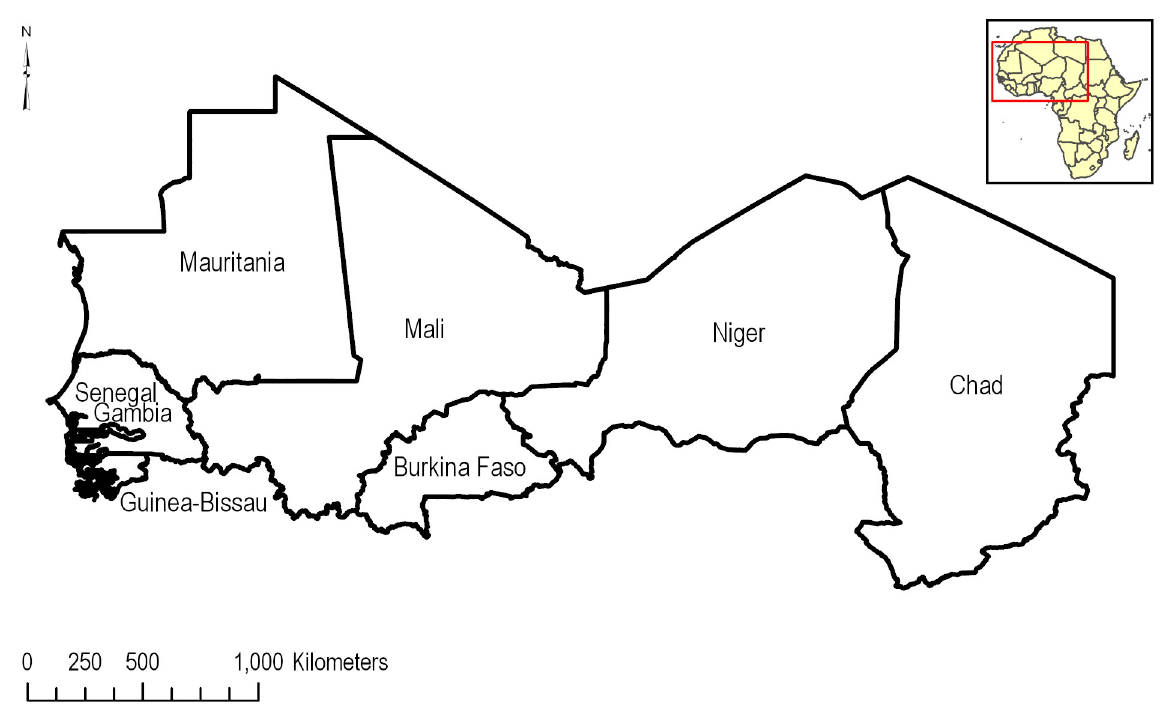
Fig 1. CILSS countries considered in the assessment of vulnerable soils under corn and cotton